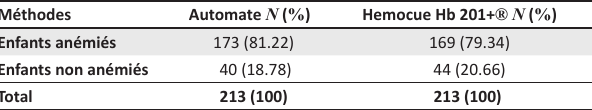
TABLEAU 3: Prévalence de l’anémie à partir des deux méthodes de dosage. Méthodes